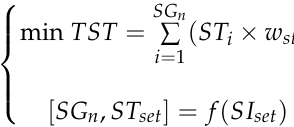
Figure 1. Regenerative braking power utilization.